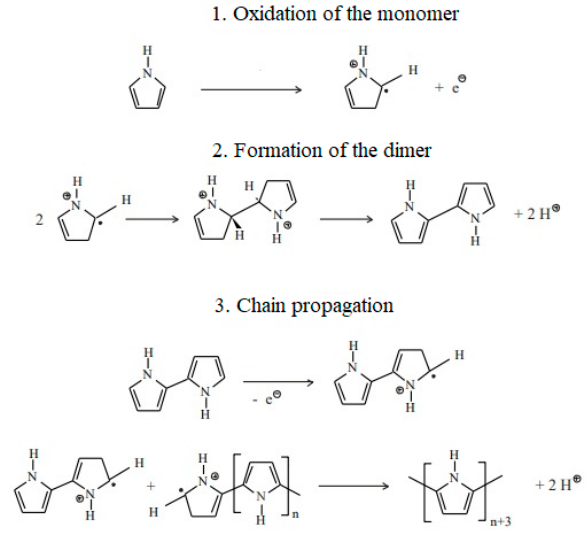
Figure 1. Mechanism of pyrrole electropolymerization [28].